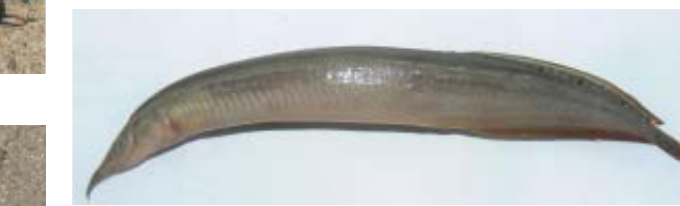
Image 23. Onestripe Spiny Eel Macrognathus